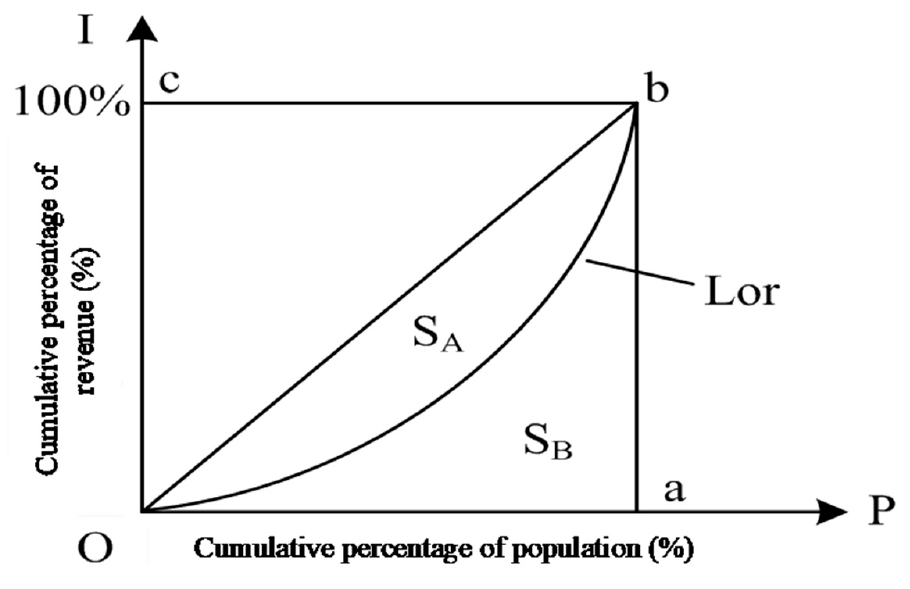
Figure 1. Lorenz